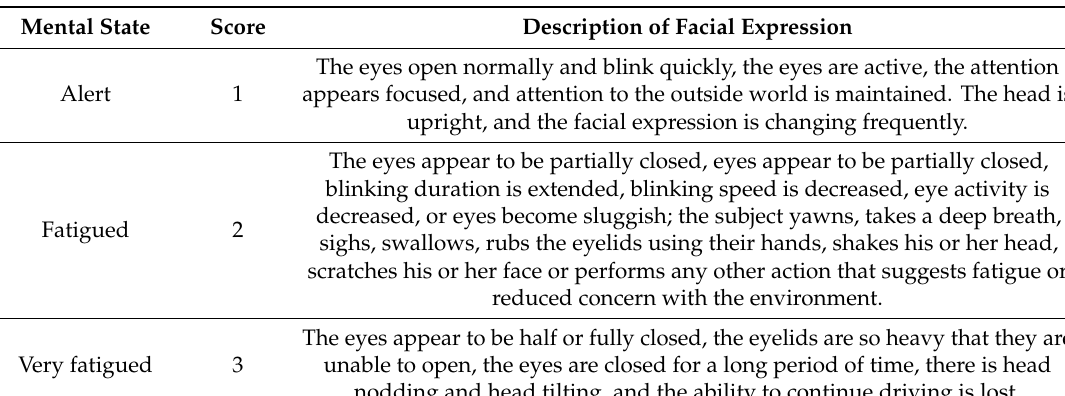
Table 2. Subjective scores for driver’s mental state